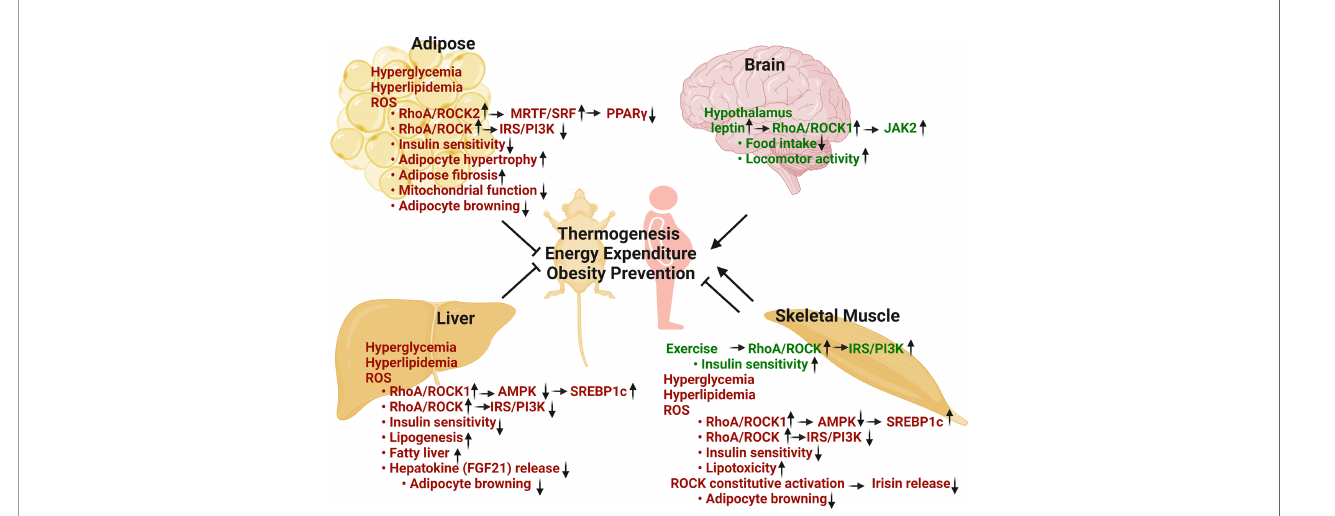
FIGURE 1 | Metabolic regulation of RhoA/ROCK pathway in thermogenesis, energy balance, obesity prevention and insulin sensitivity. Adipose RhoA/ROCK activation, caused by metabolic stresses including hyperglycemia, hyperlipidemia and ROS, is associated with disease phenotypes. Total ROCK activity and ROCK2 activity are negative regulators of thermogenic, adipogenic, and mitochondrial gene expression via stimulation of F-actin/MRTF/SRF signaling pathway and inhibition of insulin signaling pathway. Hepatic RhoA/ROCK activation by risk-factors is also associated with aberrant regulation. Total ROCK activity and ROCK1 activity are positive regulators of lipogenic pathway through inhibition of AMPK and activation of SREBP1c. Hepatic RhoA/ROCK activities are also negative regulators of thermogenesis and insulin signaling pathway. Skeletal muscle RhoA/ROCK activation shows both bene fi cial and detrimental outcomes. ROCK activation under basal or exercise condition is critical to glucose regulation via promoting insulin signaling pathway. Conversely, ROCK activation by metabolic stresses is associated with disease through inhibition of AMPK and insulin signaling. Hypothalamic RhoA/ROCK1 activation by circulating leptin decreases body weight and adiposity through reducing food intake, increasing energy expenditure and locomotor activity (Green texts indicate bene fi cial effects in metabolism; red texts indicate detrimental effects in metabolism) (Figure is created with